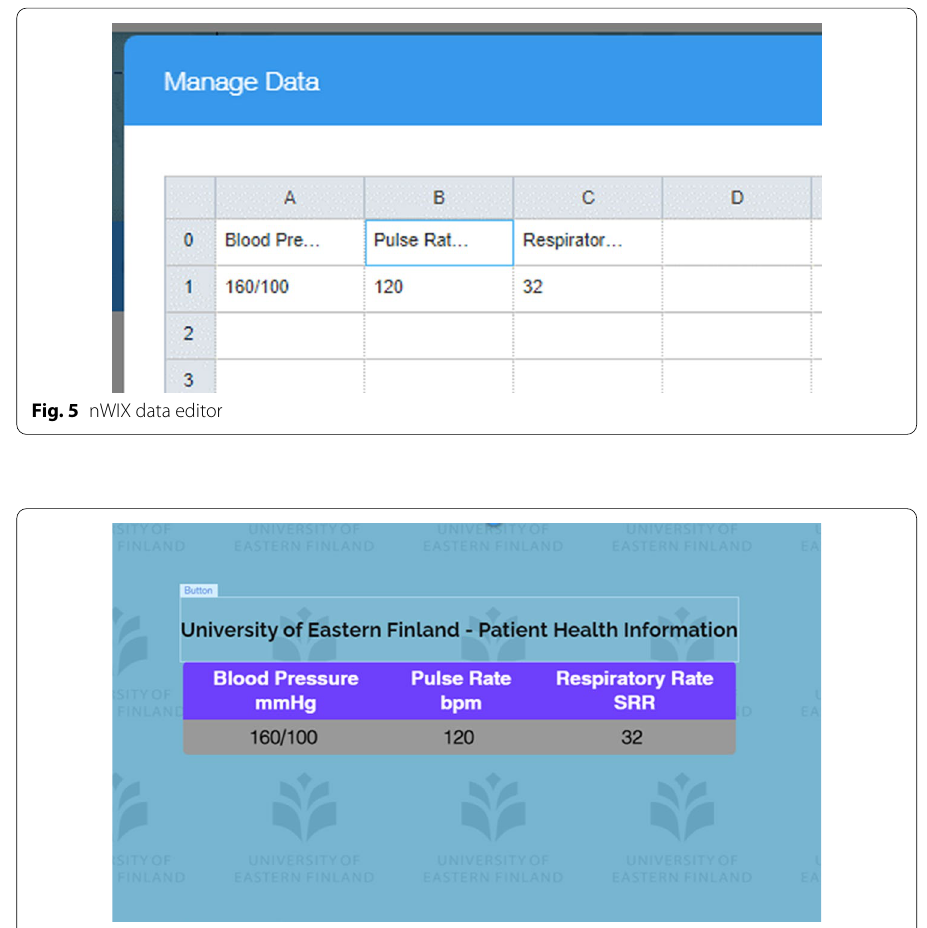
Fig. 6 Patient health information displayed on the bedside monitor